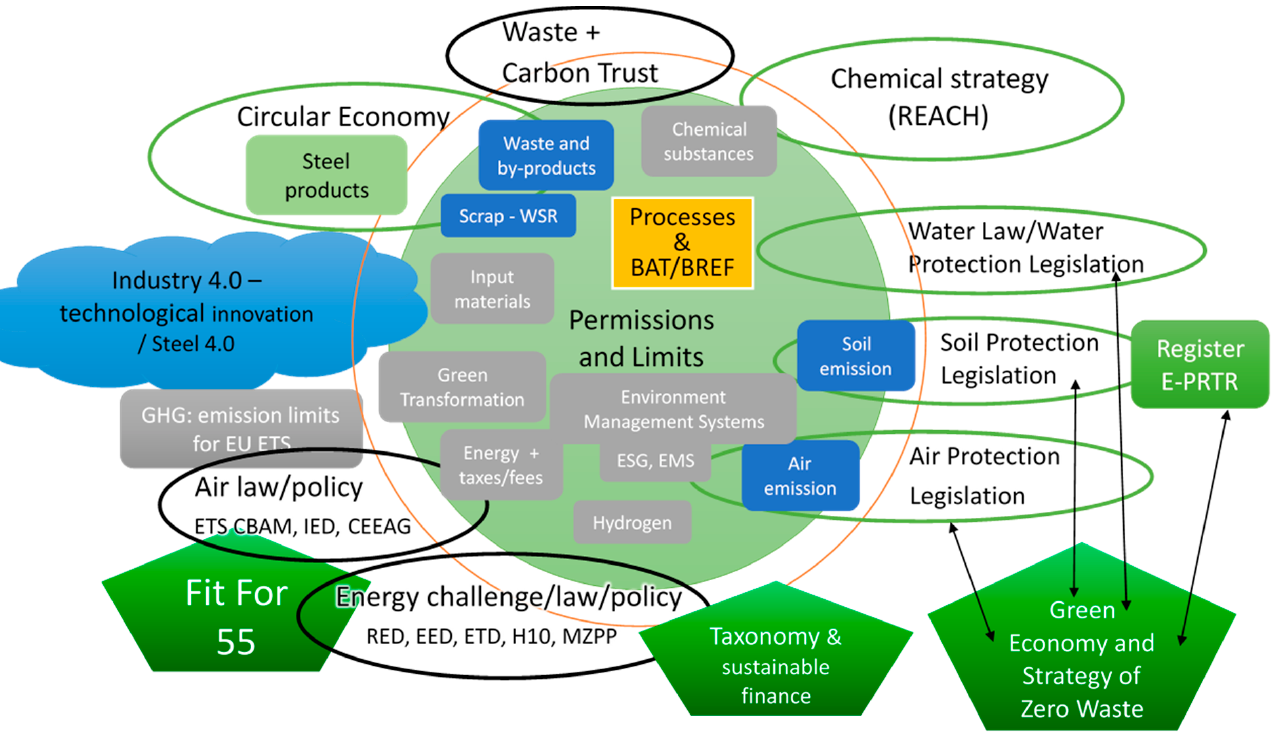
Figure 1. Environmental segments determining the development of the steel sector in Poland in Industry 4.0 conditions.